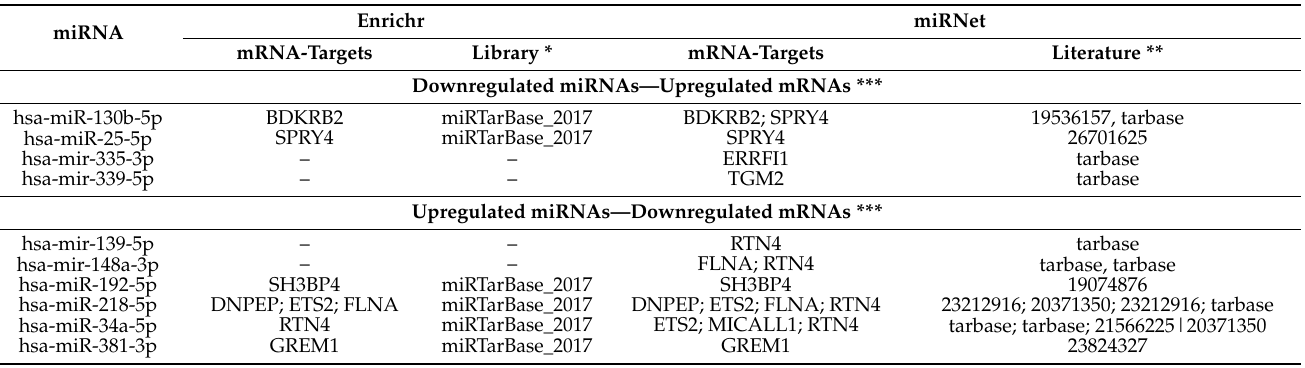
Table 3. Relationships between differentially expressed common mRNAs and miRNAs of BR3 and U87 MG GBM neurospheres. MicroRNA/mRNA pairs are presented, the levels of which changed in the process of NS formation in opposite